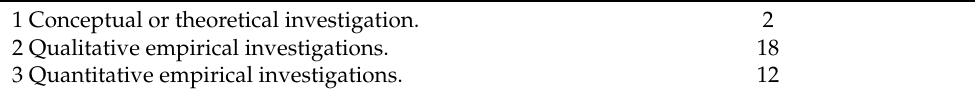
Table 4. Categories for choice of methods for papers in